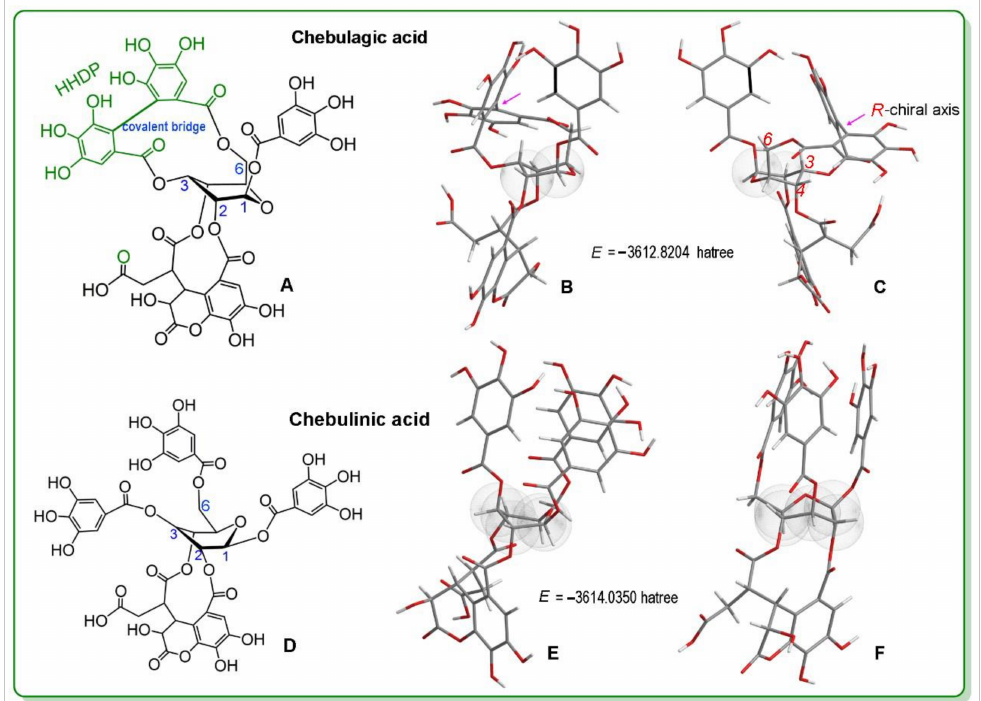
Figure 1. Structures, stable conformations, and molecular single point energies ( E ) of chebulagic acid and chebulinic acid. ( A ), structure of chebulagic acid; ( B ), stable conformation of chebulagic acid; ( C ), back view of ( B ); ( D ), structure of chebulinic acid; ( E ), stable conformation of chebulinic acid; ( F ), left view of E. HHDP, hexahydroxydiphenoyl; E , single point energy. ∆ E = E − E chebulinic acid chebulagic acid = 1.2146 Hatree = 762.1729 kcal/mol. The dot cloud indicates the glucopyranosyl ring. The pink arrows in B and C indicate the covalent bridge. R , absolute stereoconfiguration of the chiral